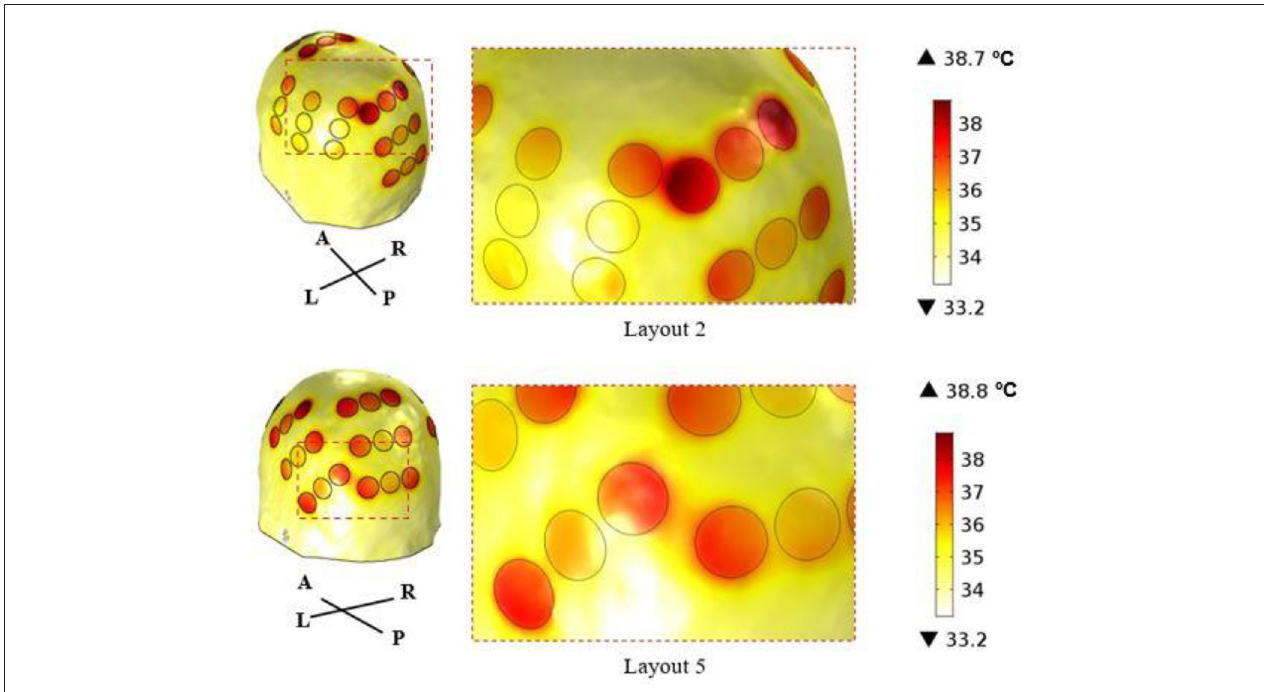
FIGURE 4 | Temperature distribution on the surface of the scalp at the end of the simulation (t = 5min) using layout 2 (above) and layout 5 (below). The circles represent the interface between the scalp and the gel, and they correspond to the regions where the maximum temperature was reached. In layout 2, the shortest distance between transducers of different arrays was 3mm, which created a common temperature hotspot in that region. In layout 5, this distance was 8mm, which was enough to avoid its